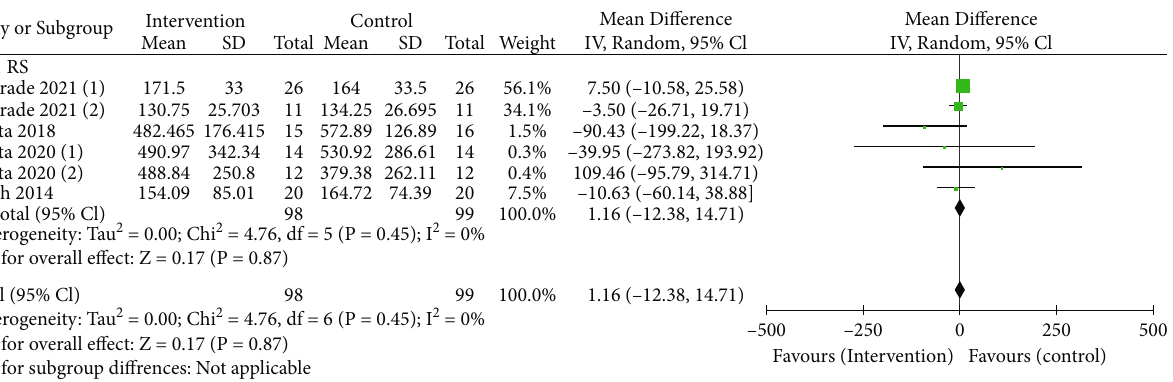
(1)4.5.1 RS Andrade 2021